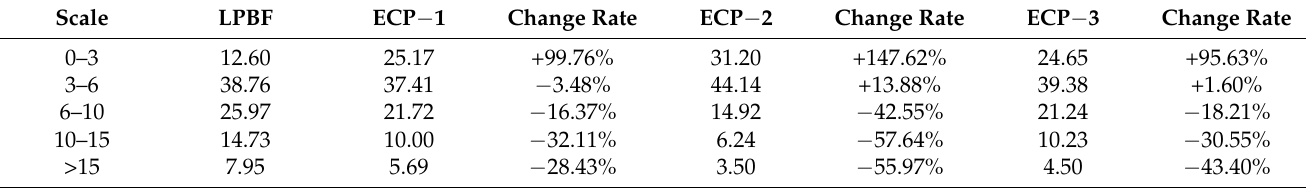
Table 7. The size distribution of α (cid:48) martensites in the LPBF-Ti64 samples before and after ECP treatment